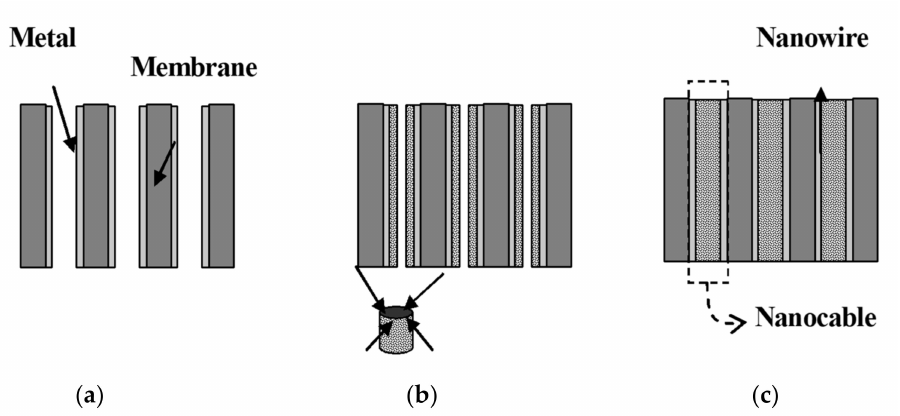
Figure 10. ( a ) Metallic nanotubes obtained inside the polycarbonate (PCTE) membrane, as electric conductive base for the electrochemical deposition of further materials. ( b ) Pores are filled by radial electrochemical deposition (arrows show the growth direction inside the pore). ( c ) Nanocable structures (i.e., filled nanotubes) formed in the PCTE